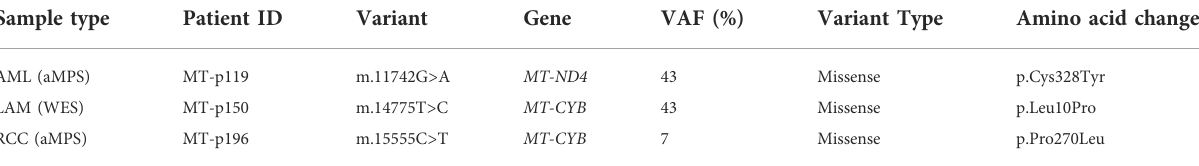
TABLE 2 In silico predicted mtDNA pathogenic